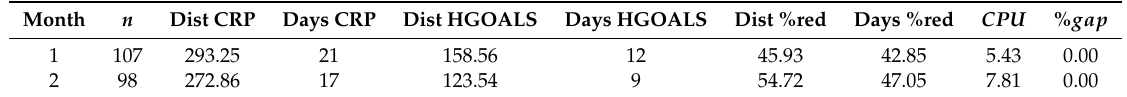
Table 12. Case study